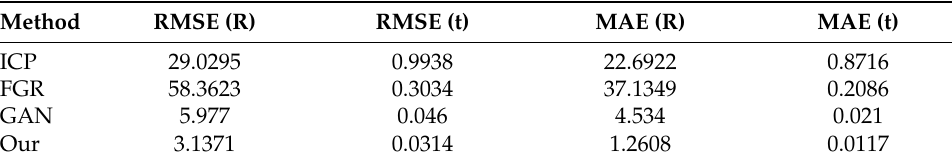
Table 5. The results of point clouds with unseen categories.